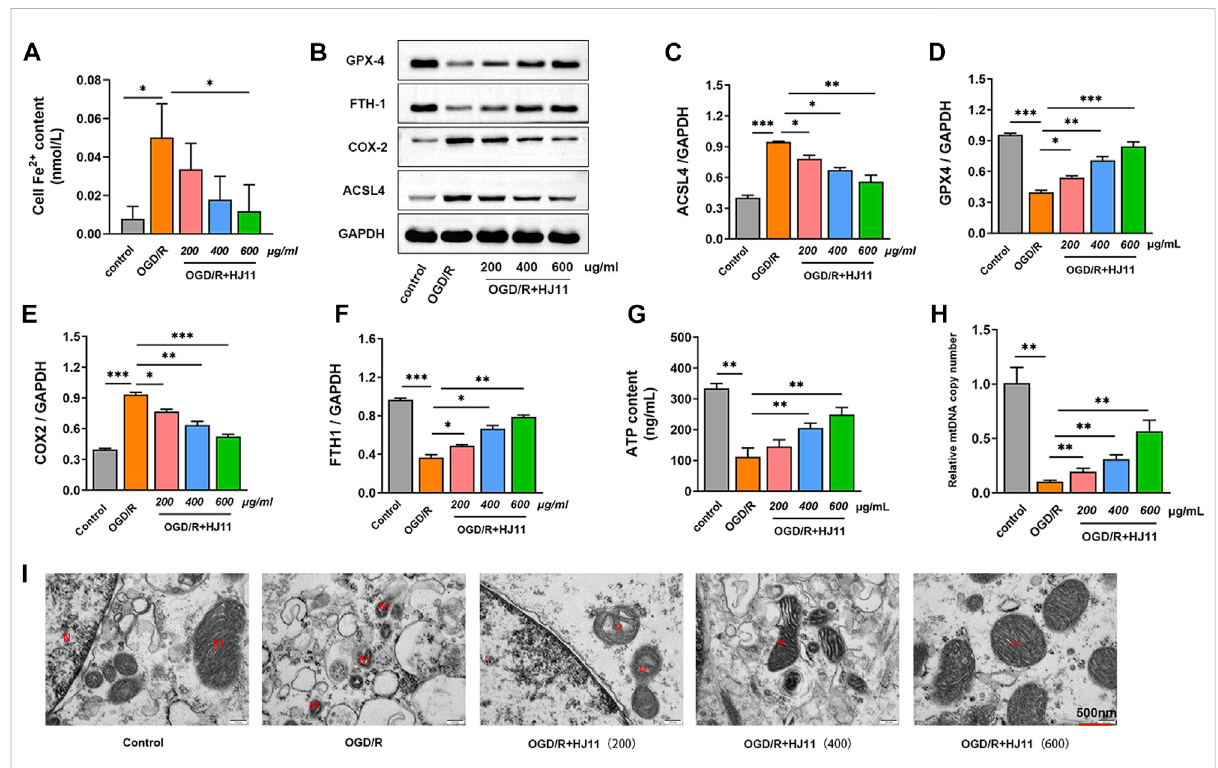
Effects of HJ11 decoction on iron accumulation and mitochondrial damage in H9c2 cells. (A) HJ11 decoction decreased the level of iron accumulation in oxygen glucose deprivation-reperfusion (OGD/R) – induced H9c2 cells. (B – F) Representative western blot images for ferroptosis- associated proteins in H9c2 cells. Statistical analysis of western blots illustrating that HJ11 decoction inhibited the expression of ACSL4 and COX2proteinsbutpromotedtheexpressionofFTH1andGPX4proteinsintheOGD/R-inducedH9c2cells. (G,H) HJ11decoctionincreasedthe levels of adenosine triphosphate (ATP) and mitochondrial DNA (mtDNA) in the OGD/R-induced H9c2 cells. (I) Representative transmission electron microscopy images of mitochondria, indicating that HJ11 decoction alleviated mitochondrial damage in the OGD/R-induced H9c2 cells. Scale